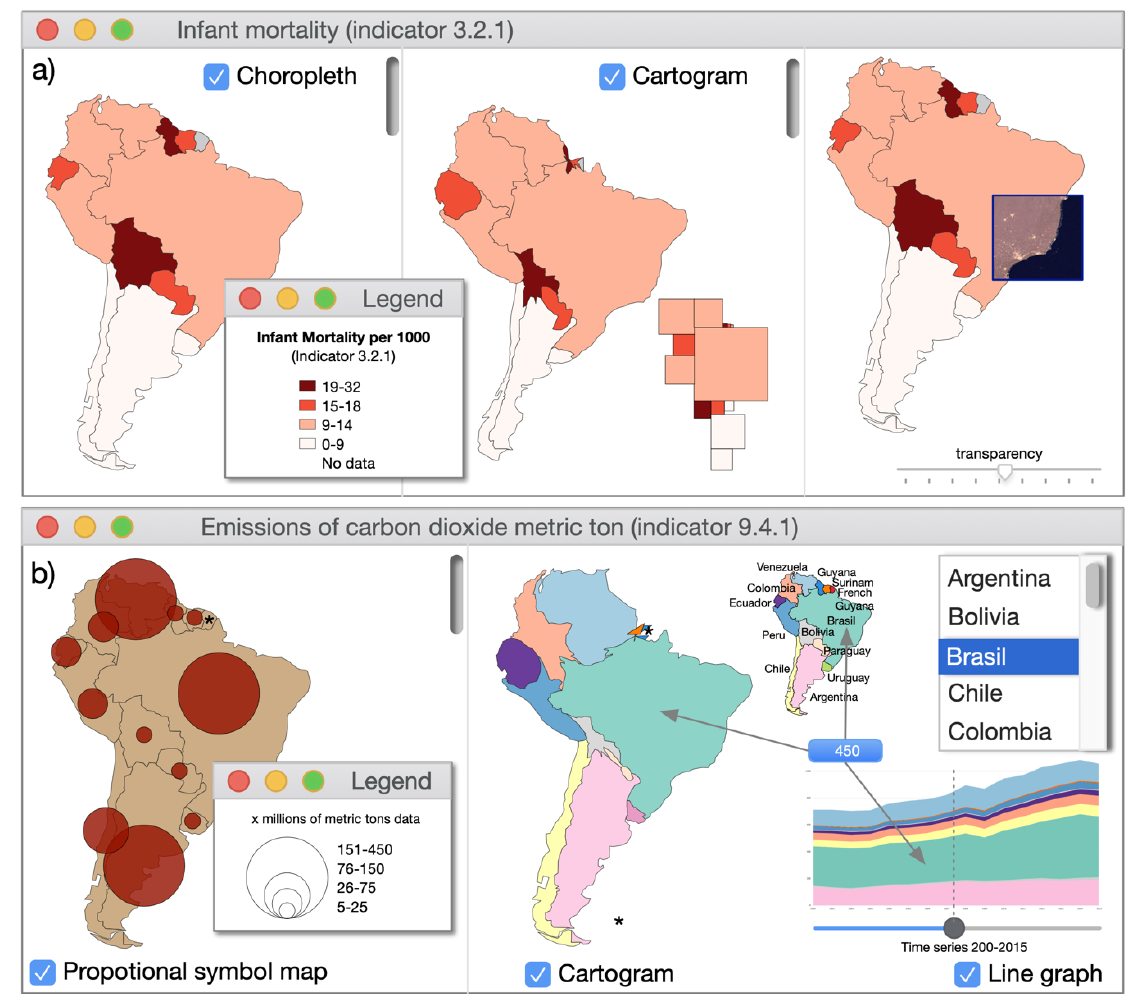
Figure 7. Alternative mappings: ( a ) Infant mortality (indicator 3.2.1): left: a traditional choropleth; centre: two types of cartograms; right: transparent choropleth with night-time light basemap; ( b ) Emissions of carbon dioxide (indicator 9.4.1): left: a proportional point symbol map; right: linked cartogram, line graph of time series and basemap.